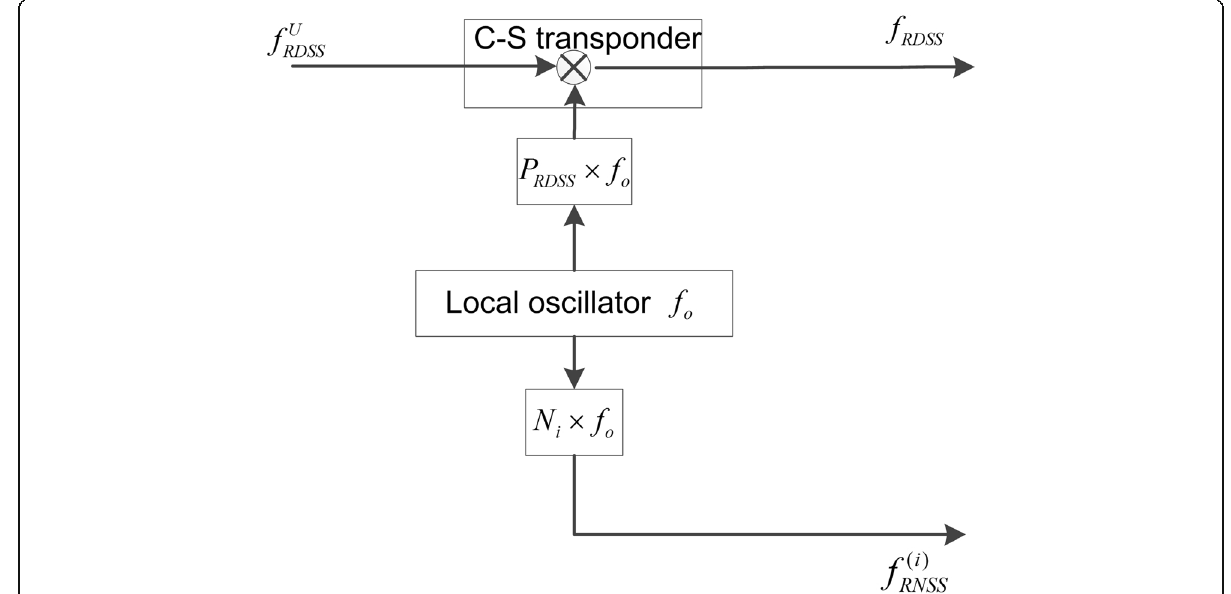
Fig. 2 RDSS and RNSS on-board signal carrier frequency